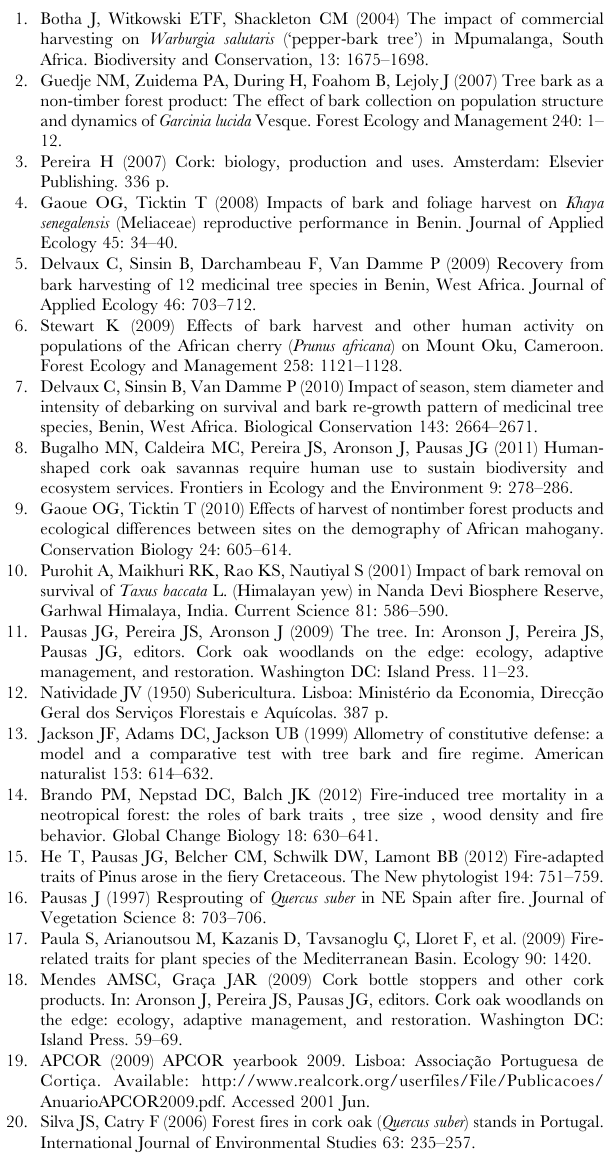
Table S1 Main characteristics of the 22 study sites. Table S2 List of the main tree characteristics by site. Table S3 List of the main post-fire tree responses by site. Table S4 Summary of the sequential ANOVA for each post-fire response